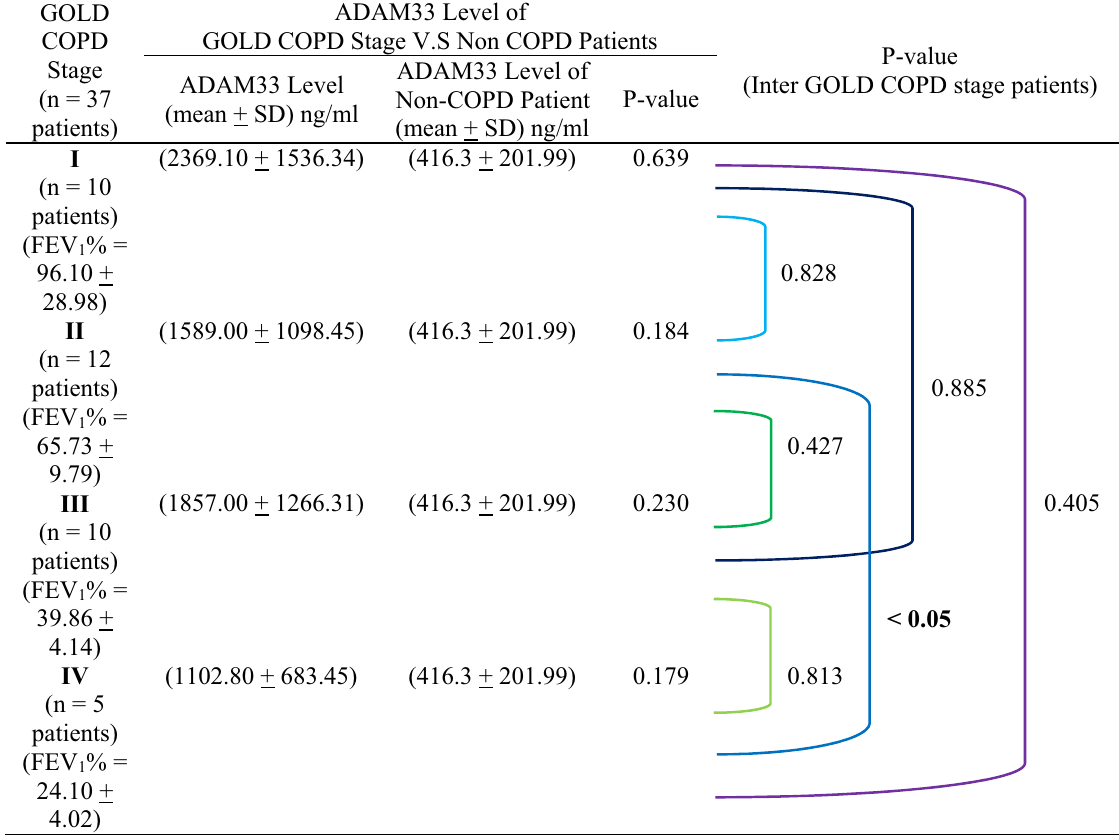
Table 8. The correlation of ADAM33 level between COPD and non-COPD patients according to GOLD COPD stage and their inter GOLD COPD stage.